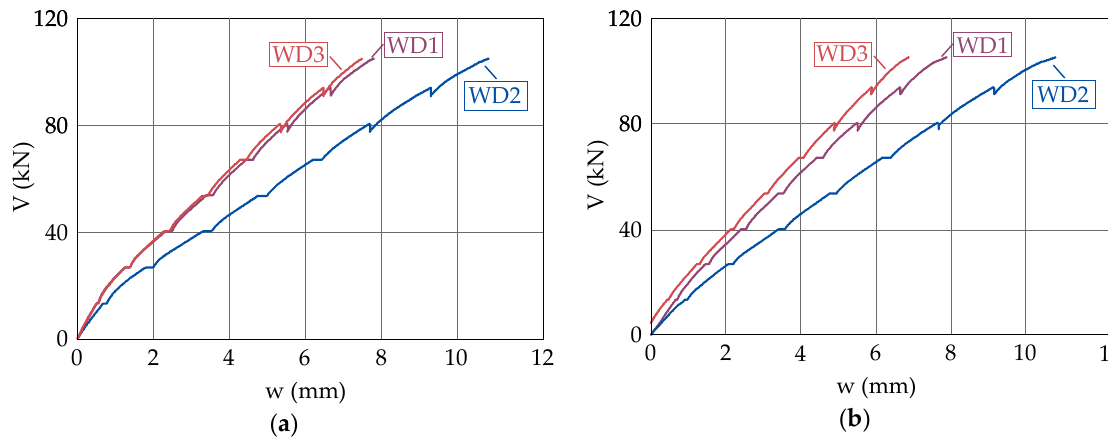
Figure 6. Shear force—deflection curve: ( a ) B1-1 and ( b ) B1-2.